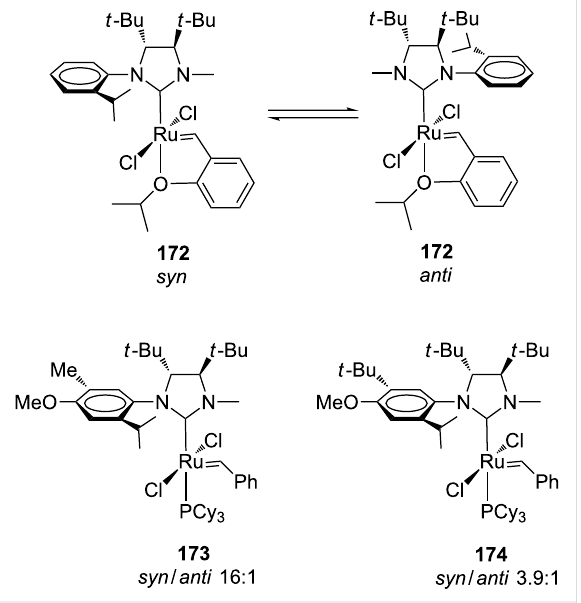
Figure 32: Hoveyda ( 172 ) and Grubbs-type ( 173 , 174 ) backbone- substituted C 1 -symmetric NHC complexes.